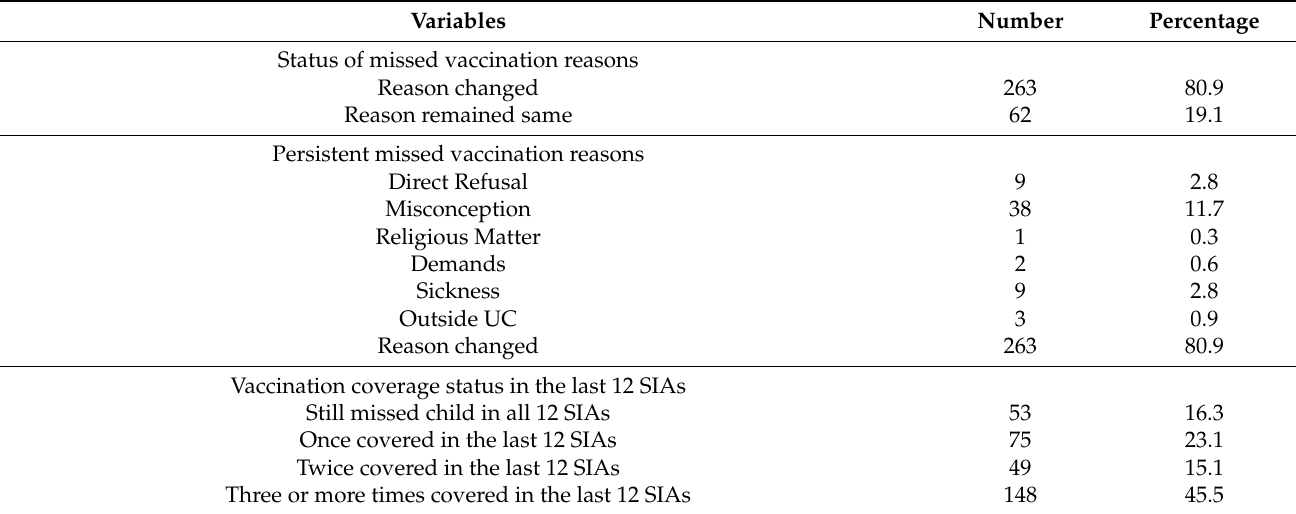
Table 3. Status of persistently recorded missed children in 34 High-Risk Union Councils of Karachi division, Sindh,